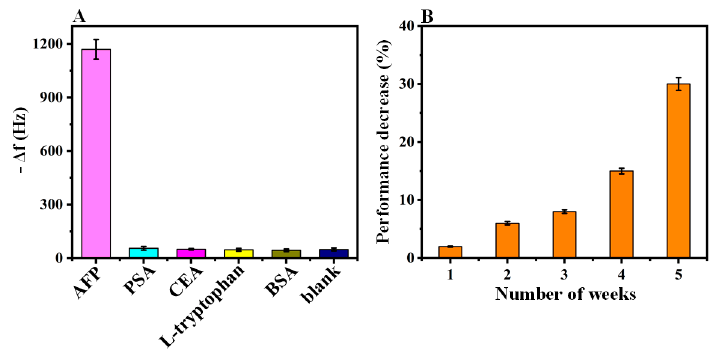
Figure 7. Comparison of gold staining amplified responses of the SAW immunosensor for AFP with nonspecific targets: concentrations of analytes were 10 ng/mL AFP, 10 ng/mL PSA, 10 ng/mL CEA, 10 ng/mL L-tryptophan, 10 ng/mL BSA, and 0 ng/mL AFP. ( A ) Storage stability of the SAW immunosensor at 4 °C. Error bars show the mean ± SD of three measurements ( B ).